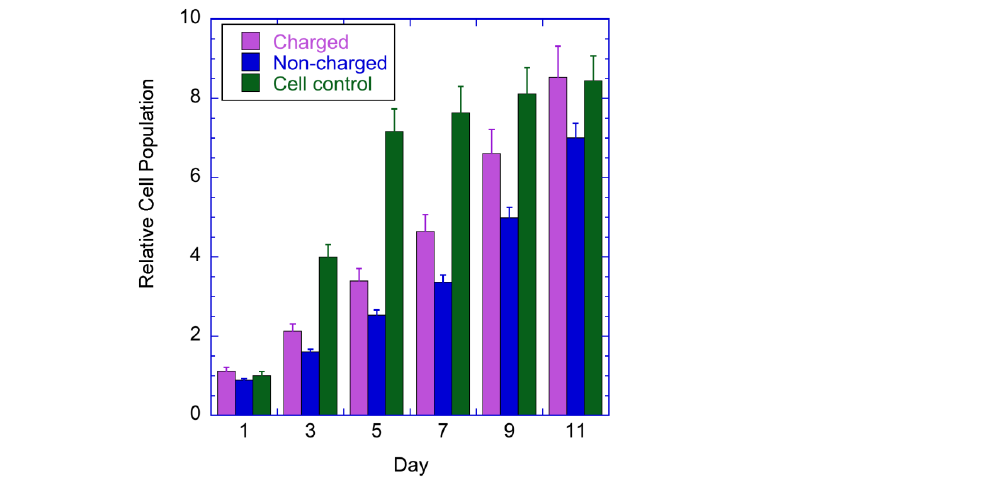
Figure 7. Osteoblastic cellular proliferation in the charged and non-charged coatings for increasing culture times. culture